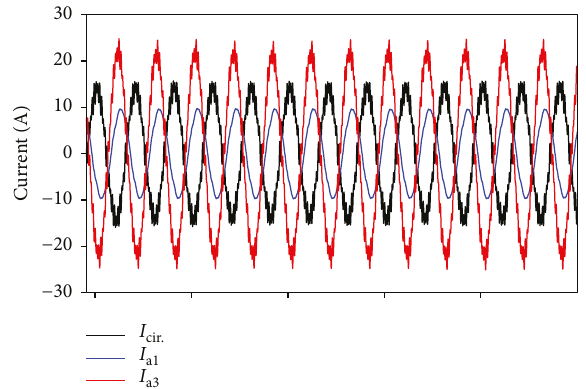
Figure 24: Circulating current with two-winding coupled inductors with a magnetizing inductance of